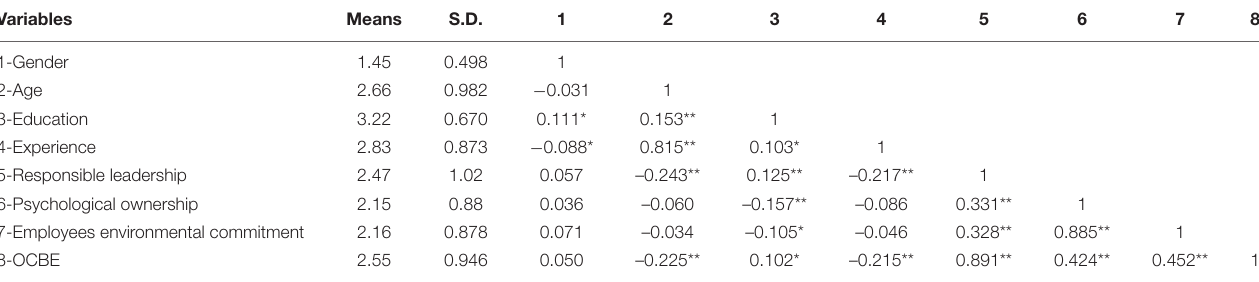
TABLE 4 | Means, standard deviations, matrix for study variables. Variables